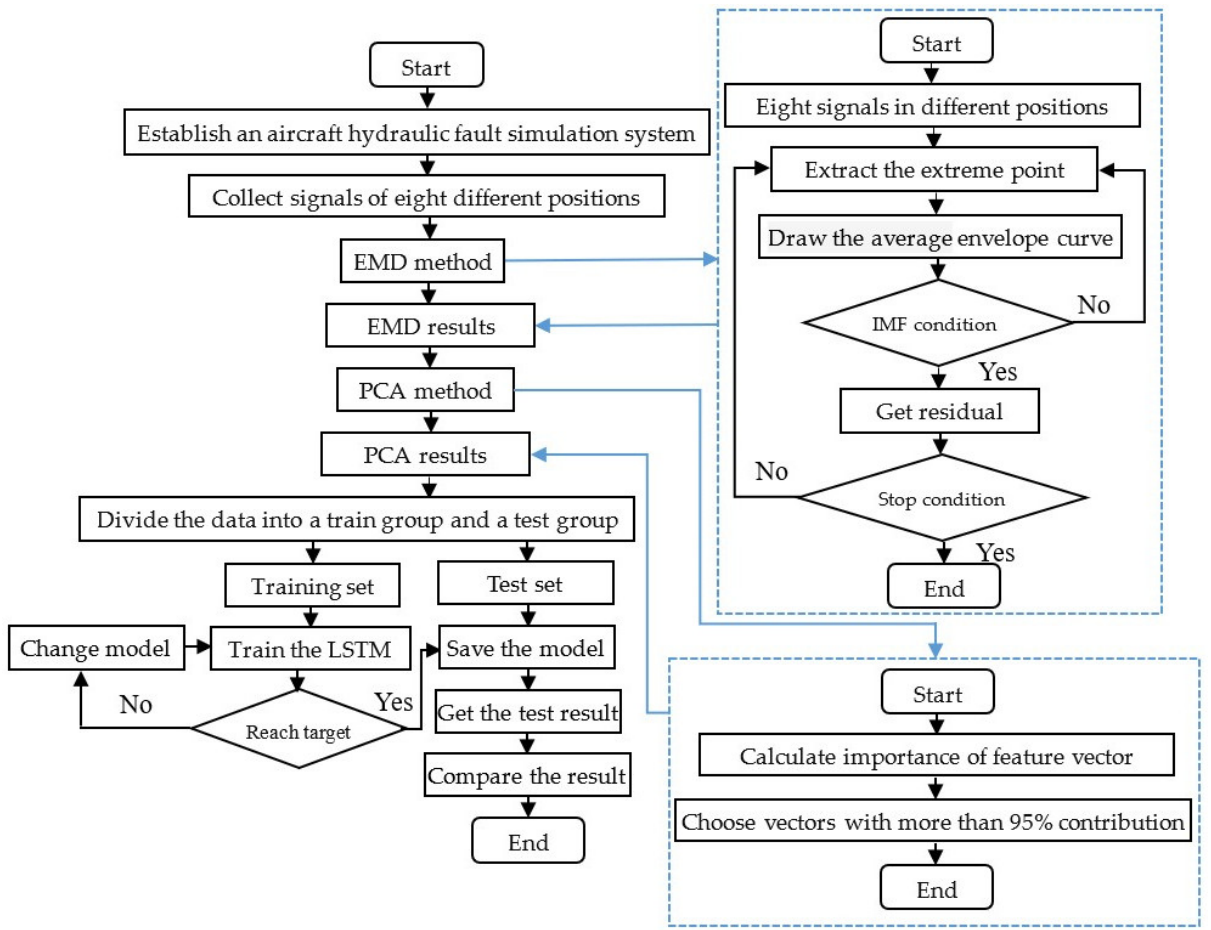
Figure 8. The flow chart of the EMD-LSTM fault diagnostic method for aircraft hydraulic system.